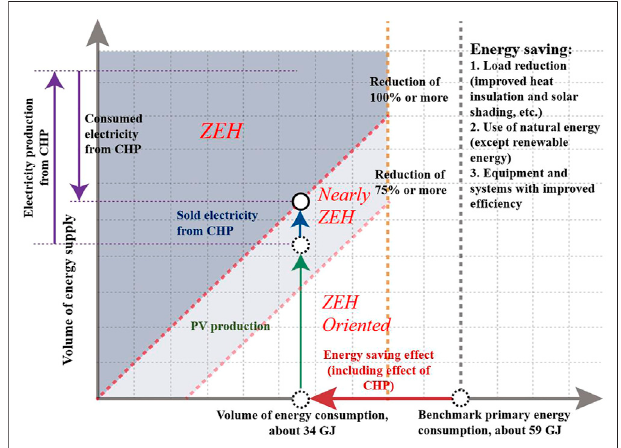
FIGURE 2 | De fi nition and evaluation method of Japanese